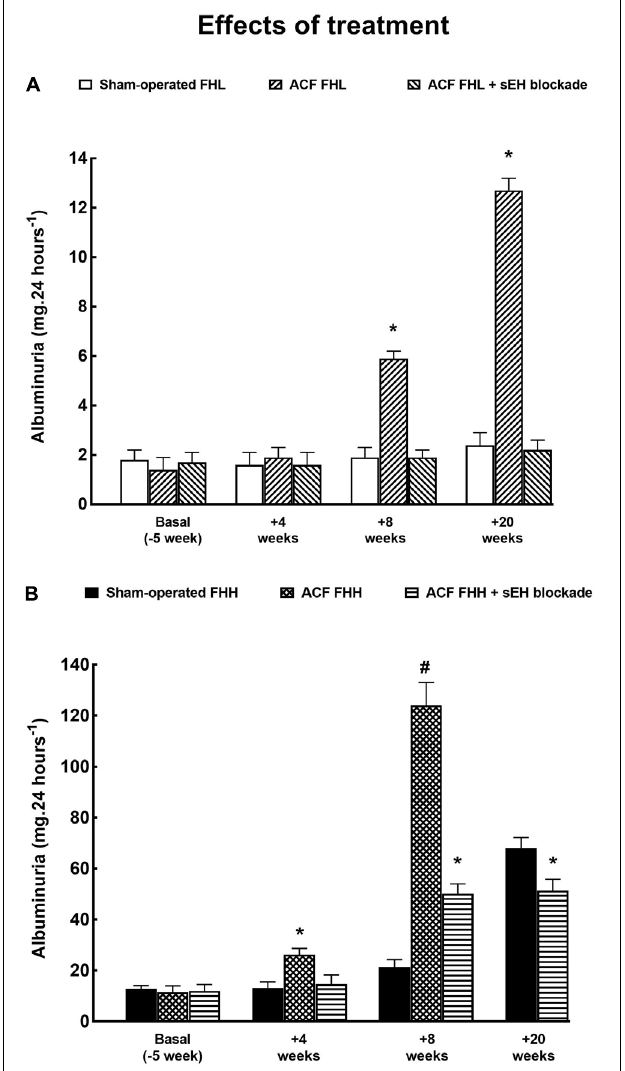
FIGURE 4 | (A) Albuminuria in sham-operated FHL with ACF and in ACF FHL rats treated with a sEH inhibitor. (B) Albuminuria in sham-operated fawn-hooded hypertensive (FHH) rats, untreated ACF FHH, and ACF FHH treated with sEH inhibitor. ∗ P < 0.05 compared with sham-operated counterparts at the same time point. # P < 0.05 ACF FHH rats compared with ACF FHH rats treated with sEH inhibitor (at the same time point).